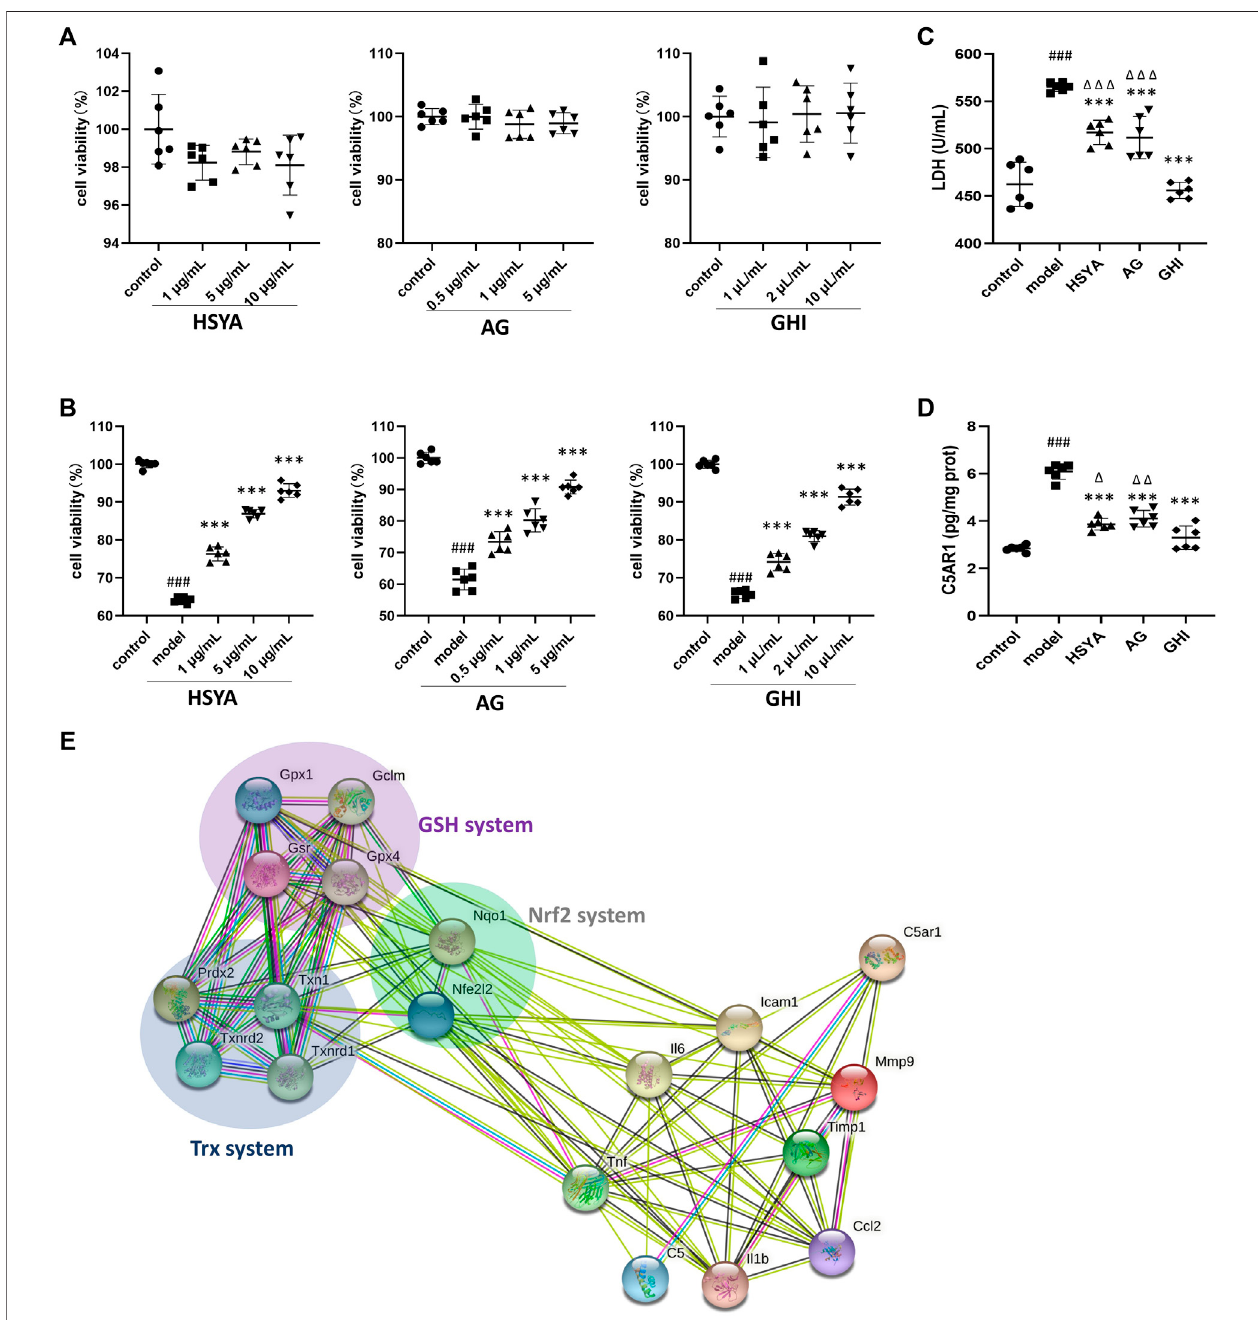
FIGURE8| GHI,HSYA,andAGprotectedagainstC5a-inducedneurotoxicityinNeuro-2acells. (A) ViabilityofNeuro-2acellsonlytreatedwithHSYA,AG,andGHI ( n =6); (B) viabilityofNeuro-2acellsintheC5a-inducedcellmodel( n =6); (C) LDHlevels( n =6); (D) ELISAofC5AR1( n =6); (E) theassociationnetworkofGHI-reversed targetsin the three antioxidant systems and the reversed in fl ammation targets in this research by the String database. ### p < 0.001 compared with control, *** p < 0.001 compared with the model group, ^ p < 0.05, ^^ p < 0.01, and ^^^ p < 0.001 compared with the GHI group.